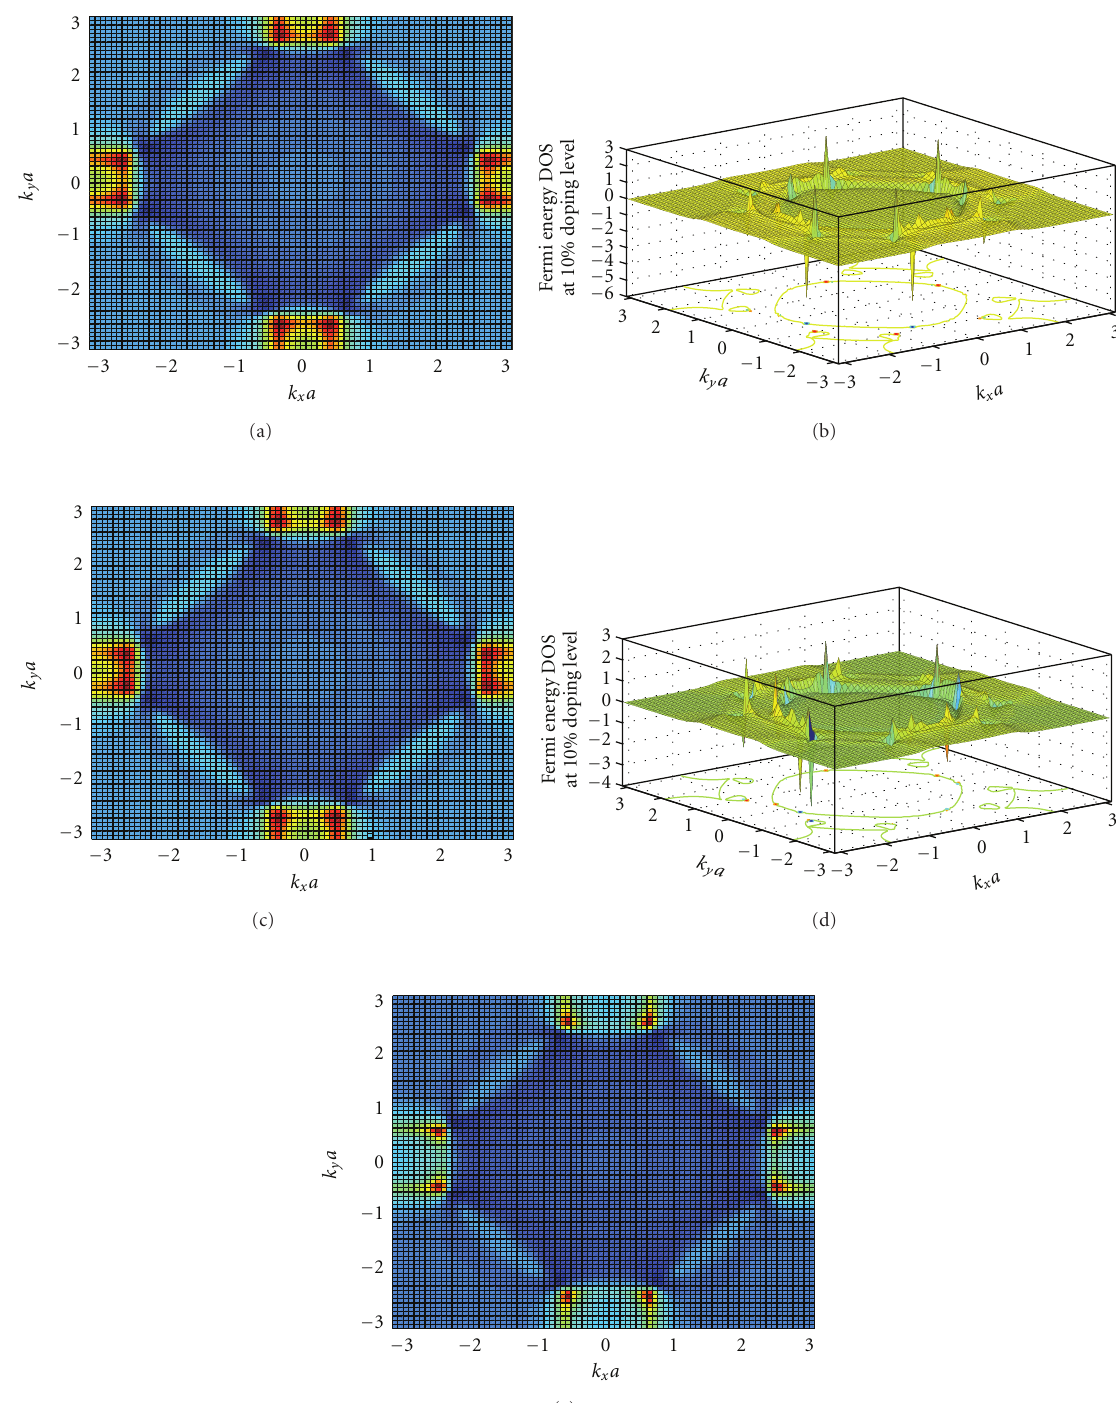
Figure 2: The contour/3D plots of the Fermi energy DOS on the Brillouin zone (BZ) at 10% hole doping, | t (cid:3) /t | = 0 . 4 (except (e)) and B = 0. (a) The anisotropy parameter ´ ε = 0 and the level broadening factor γ = 0 . 0357eV. (b) ´ ε = 0 and γ = 0 . 2436eV. (c) ´ ε = 0 . 05 and γ = 0 . 0357eV. (d) ´ ε = 0 . 05 and γ = 0 . 2436eV. (e) ´ ε = 0 . 05, γ = 0 . 0357eV, and | t (cid:3) /t | = 0 . 5. The scale of the plots in Figures 2(a), 2(c) and 2(e) is from − 0 . 2 to 1.2. In the weak disorder regime we obtain prominent electron pockets and barely visible hole-like patches. In the strong disorder regime the scenario does not change radically. We have assumed Σ e = 0 . 05eV above.The comparison of figures 2(a) with 2(c) (and figures 2(b) with 2(d)) indicates the slight change (Pomeranchuk distortion) in the topology of the Fermi surface due to ´ ε / = 0; electron pockets around (0, ± π ) widen slightly compared to those around ( ± π ,0). (e) The figure indicates that the higher value of the ratio | t (cid:3) /t | may lead to the disappearance of the electron